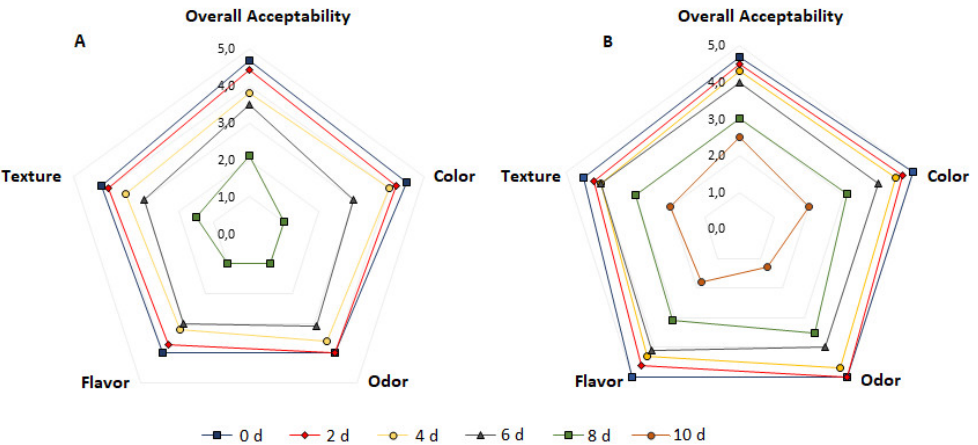
Figure 4. Sensory profile of chicken breast fillets without ( A ) and with ( B ) the EC antimicrobial coating stored at 4 °C.